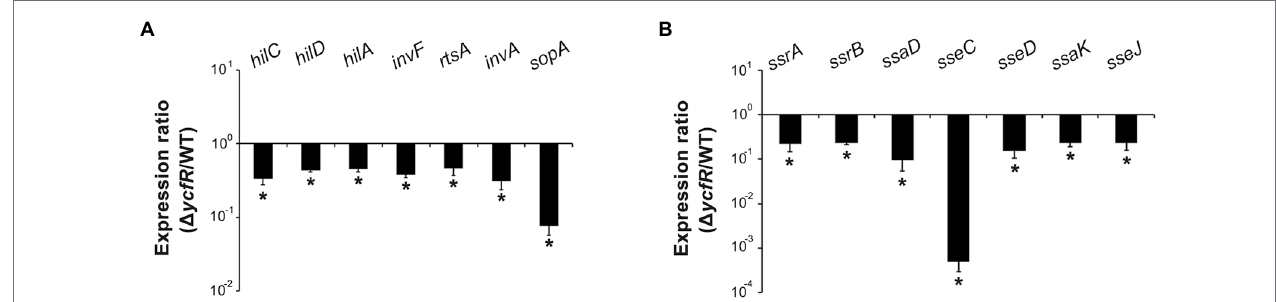
FIGURE 2 | Expression of SPI-1 and Salmonella pathogenicity island-2 (SPI-2) genes in Δ ycfR mutant. (A) Transcription levels of SPI-1 genes were examined using RNA isolated from Salmonella strains grown in LB medium broth for 2 h. The Ct values of qRT-PCR were normalized using those of gyrB and the fold-change between wild-type and Δ ycfR mutant strains was plotted. (B) To analyze the expression of SPI-2 genes, Salmonella strains were cultivated in LB medium broth for 10 h and subjected to RNA extraction. Ct values of each gene were subtracted from those of gyrB for normalization, and the fold-change ( Δ ycfR /wild-type) was calculated. An asterisk indicates a difference of a value of p < 0.05.